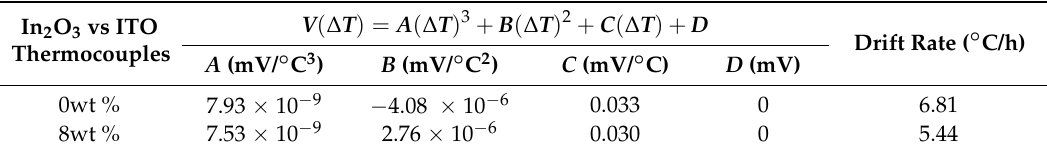
Table 2. Seebeck coefficients of In 2 O 3 /ITO thermocouples with different glass additives measured at 1270 °C.